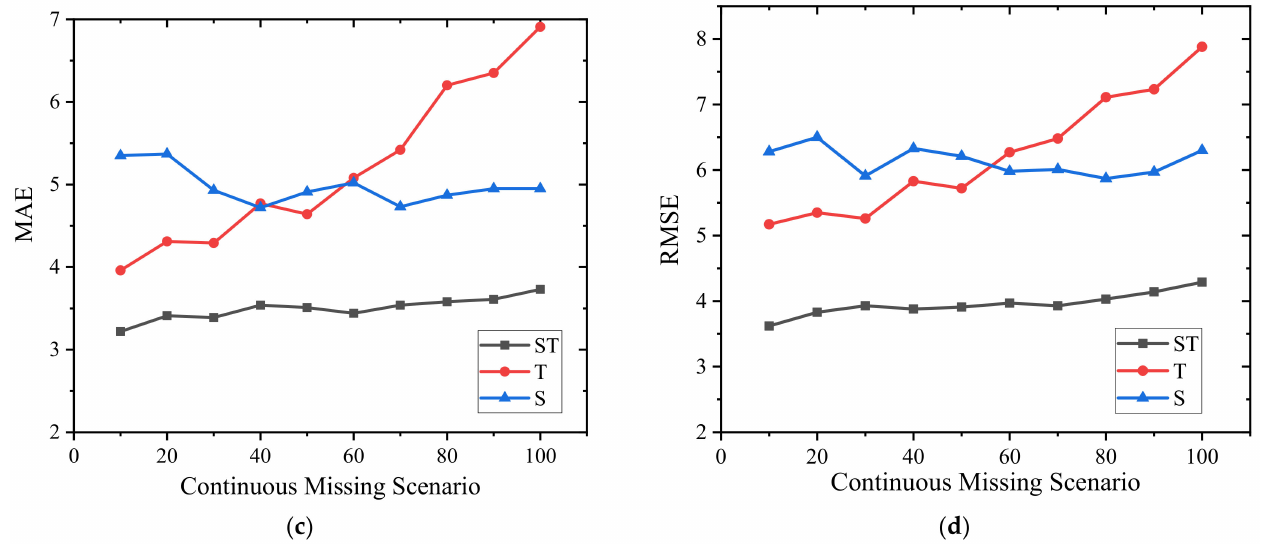
Figure 7. Temporal and spatial correlations in random and continuous missing scenarios: ( a ) MAE results considering ST, T, and S correlations in the various random missing ratio; ( b ) RMSE results considering ST, T, and S correlations in the various random missing ratio; ( c ) MAE results considering ST, T, and S correlations in the various continuous missing scenario; ( d ) RMSE results considering ST, T, and S correlations in the various continuous missing